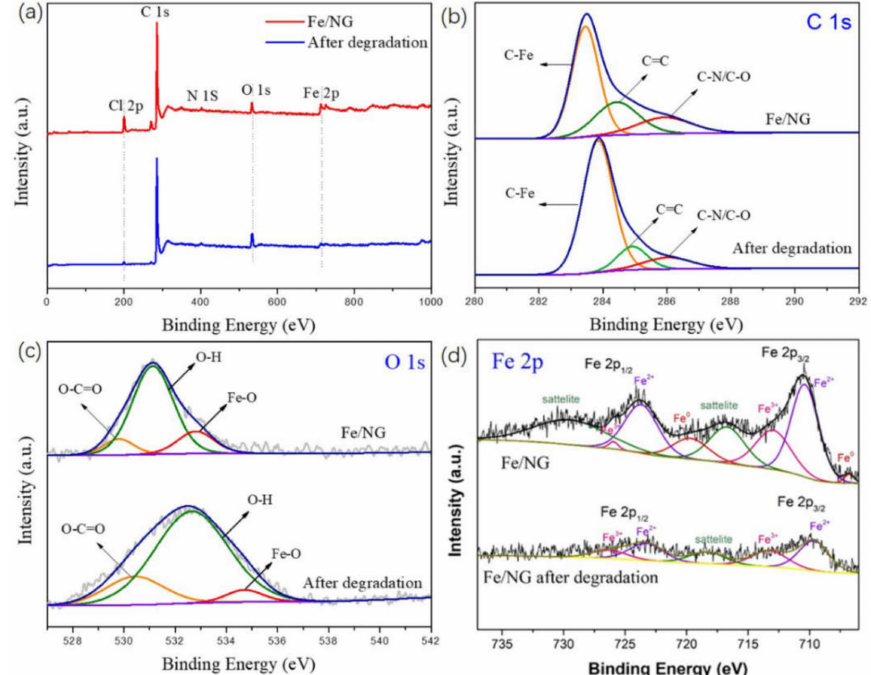
Figure 4. ( a ) XPS survey spectra of Fe/NG and after the degradation. High-resolution spectra of